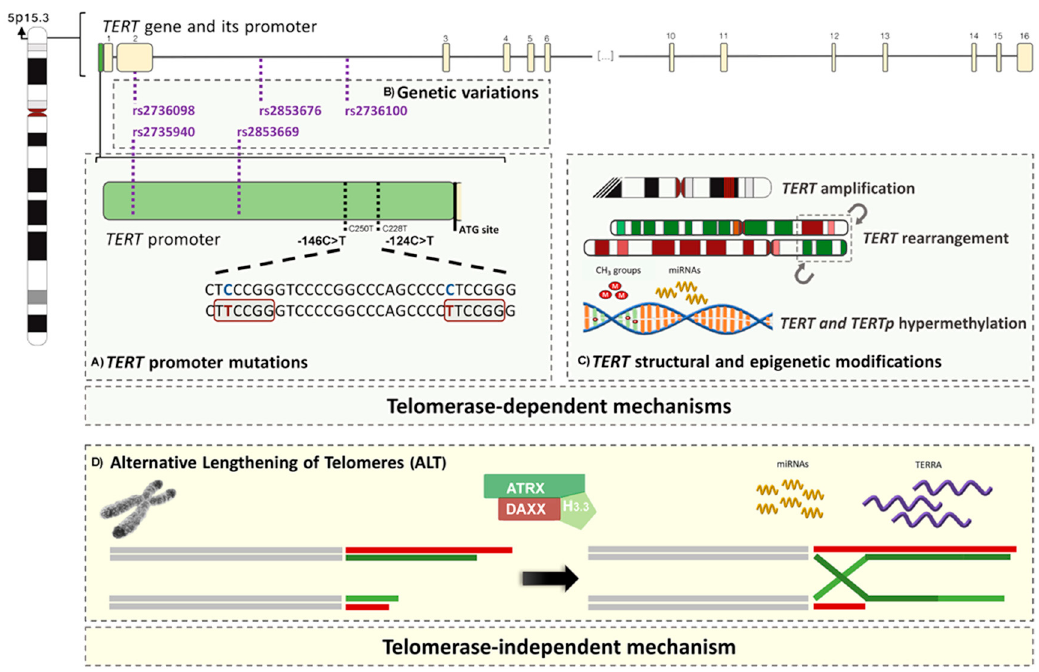
Figure 1. Telomerase-dependent ( A , B ) and -independent ( C ) telomere maintenance mechanisms (TMM) in cancer. Telomerase reactivation depends on several mechanisms that imply modifications that can have a direct impact on TERT gene regulation, which is localized at the short arm of chromosome 5; ( A ) TERTp hotspot mutations ( − 124 bp and − 146 bp upstream the ATG transcriptional start site) create binding sites for ETS transcription factors (red boxes); ( B ) Germline genetic variations of the TERTp and of intronic and exonic regions seem to associate with cancer risk; their genomic coordinates based on build 37 (GRCh 37, hg19/Human); ( C ) TERT structural variants comprise amplification and rearrangement of the gene. Hypermethylation of the TERTp or other regions, micro RNA (miRNA) regulation and post-translational histone modifications are epigenetic modifications involved in telomerase reactivation; ( D ) Alternative lengthening of telomeres (ALT) is a telomerase-independent mechanism that relies on the homologous recombination machinery of DNA repair to maintain telomere length. Mutation of the genes ATRX or DAXX and loss of protein expression are known events related to ALT. miRNAs and TERRA molecules are some epigenetic regulators of ALT. TERT : telomerase reverse transcriptase; TERTp : TERT